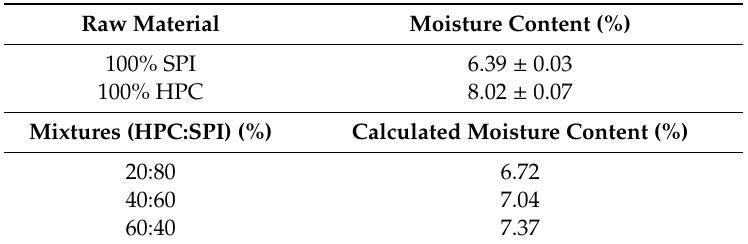
Table 1. Moisture content data for the raw materials of the mixtures.